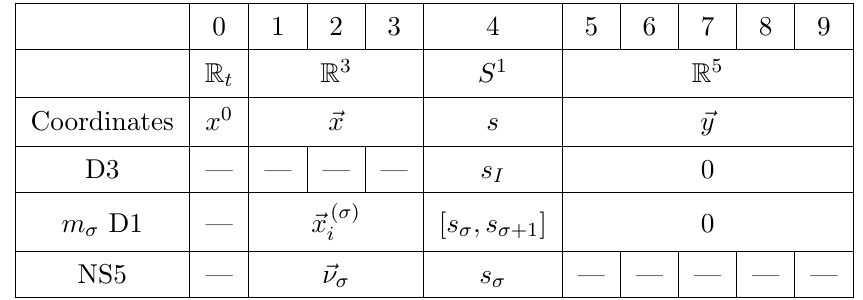
Table 2 . This table speci(cid:12)es the brane con(cid:12)guration whose moduli space of supersymmetric vacuua is described by singular monopole moduli space.